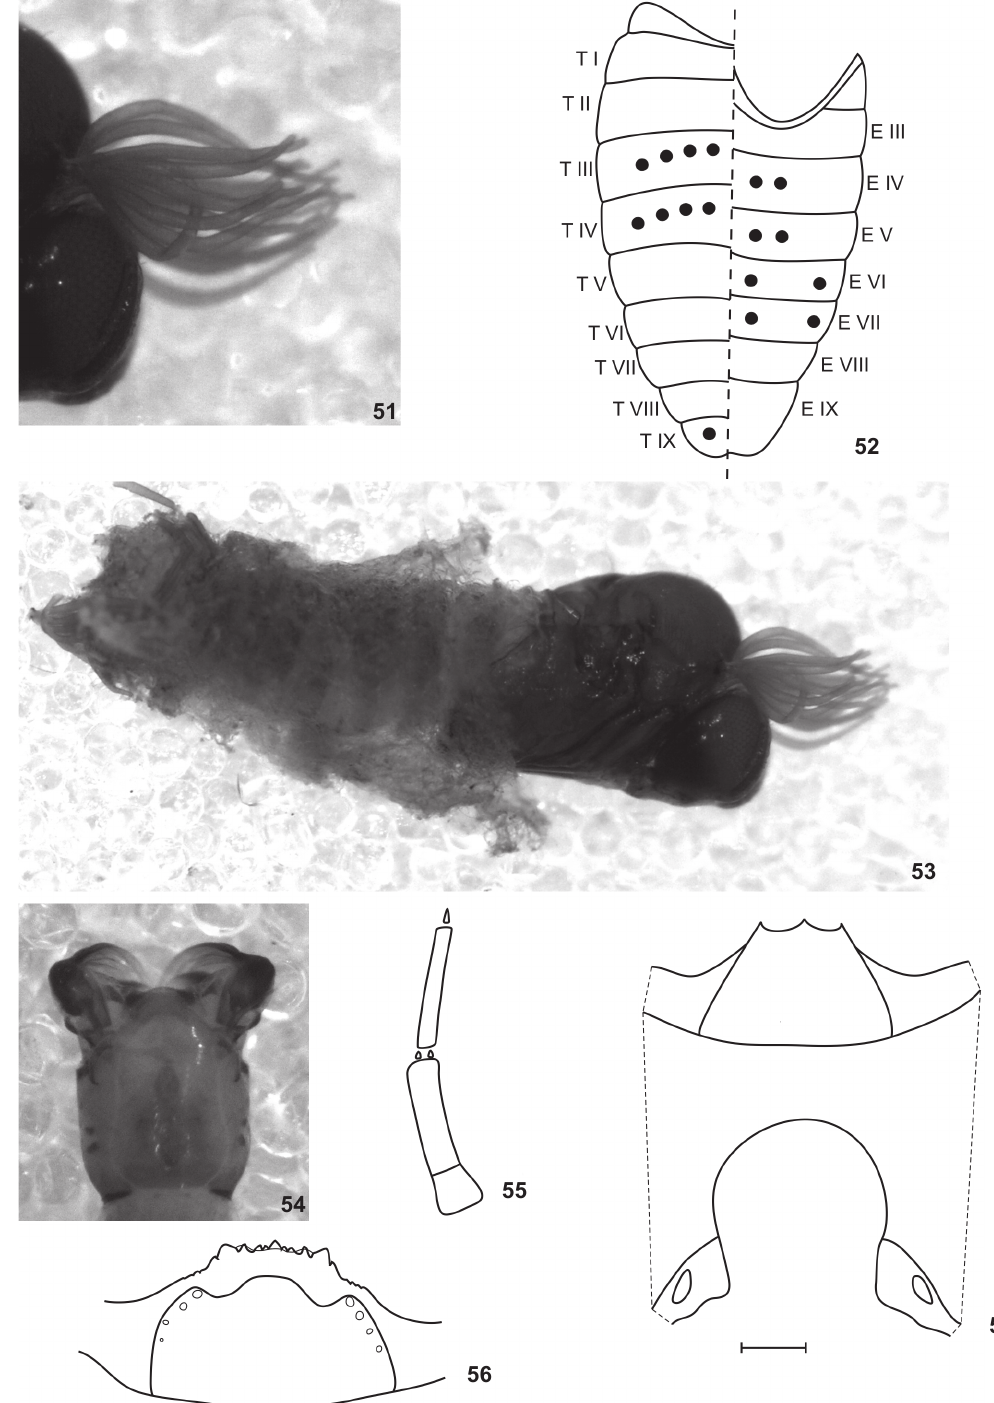
Figure 51-57. Immature of L. simplicicolor : (51-53 pupa) (51) gill; (52) abdominal chaetotaxy; (53) pupa and cocoon. (54-57 larva) (54) head capsule, dorsal view; (55) antenna; (56) hypostomal teeth; (57) head capsule, ventral view. Bar: 0.1